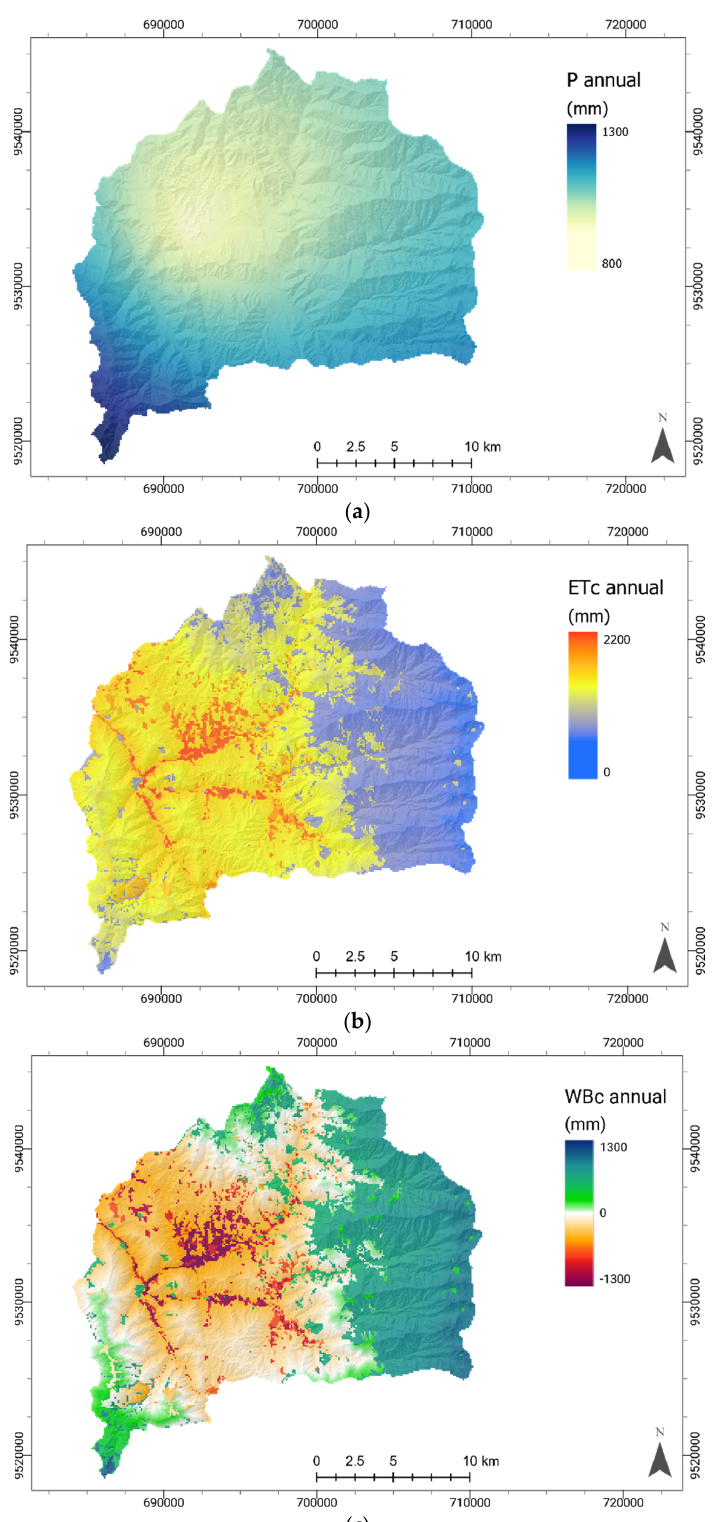
Figure 5. ( a ) Annual precipitation ( P ) of the communities Malacatos and Vilcabamba. ( b ) Annual crop evapotranspiration ( ETc ) of the communities Malacatos and Vilcabamba. ( c ) Annual specific crop water balance ( WBc ) of the communities Malacatos and